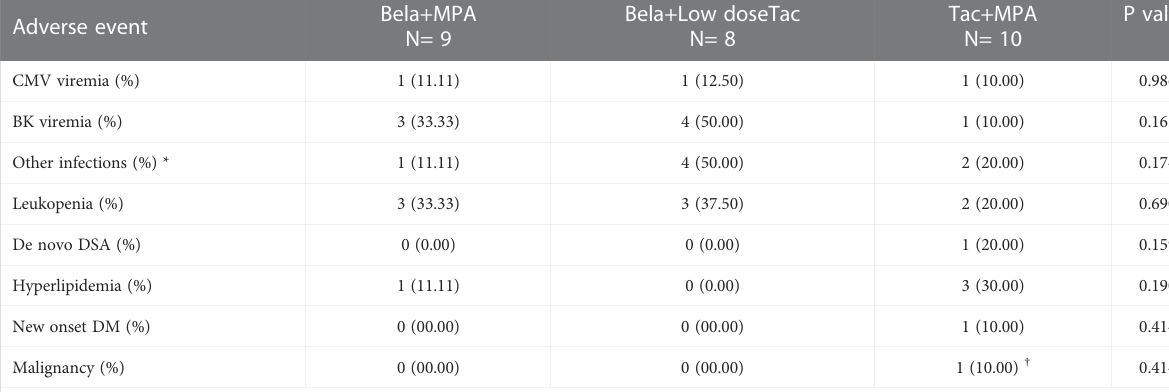
TABLE 2 Adverse events.